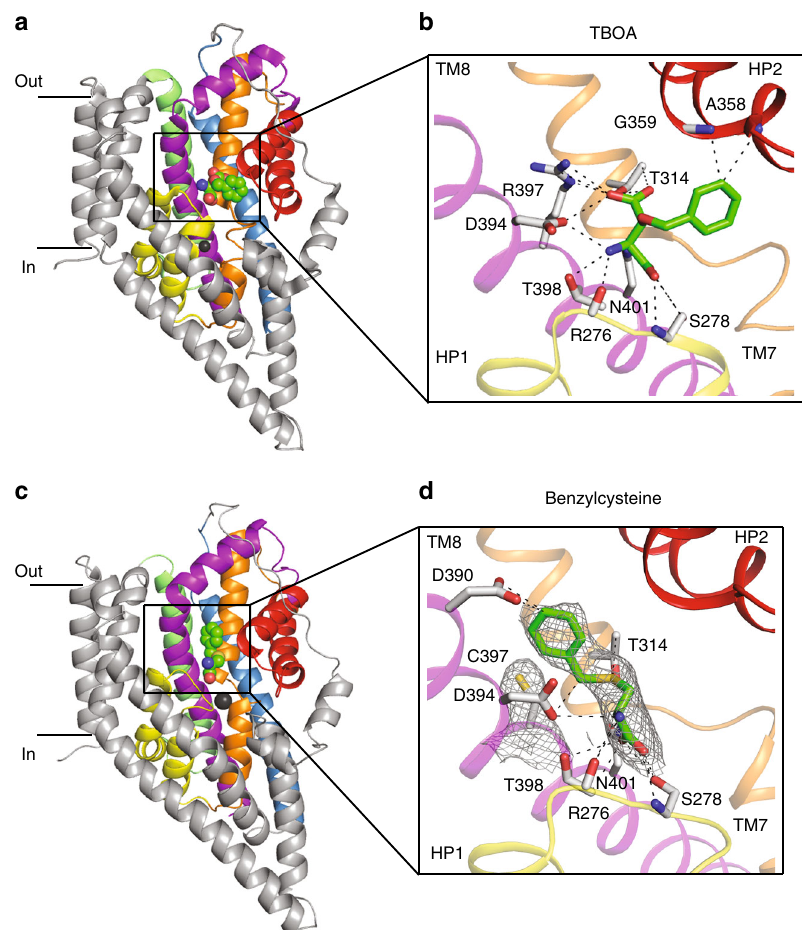
Fig. 6 Inhibitor-binding site in wild-type and mutant Glt Ph . View of a single protomer of the wild-type Glt Ph bound to TBOA (PDB:2NWW, a and Glt Ph - R397C bound to benzylcysteine c . The protomer is divided into the ‘ scaffold domain ’ (TM1, TM2, TM4 and TM5, coloured in grey) and the ‘ transport domain ’ (TM3 in blue, TM6 in green, TM7 in orange, TM8 in magenta, HP1 in yellow and HP2 in red). Bound inhibitor is shown in stick representation and Na1 and Na2 are shown as dark grey spheres. Close-up view of the TBOA b and benzylcysteine d binding sites. Interactions within 3.5 Å between bound inhibitor and residues in the Glt Ph binding site are shown as dashed lines. Averaged 2fo – fc electron density maps at 1 σ in dark grey mesh are shown for benzylcysteine and